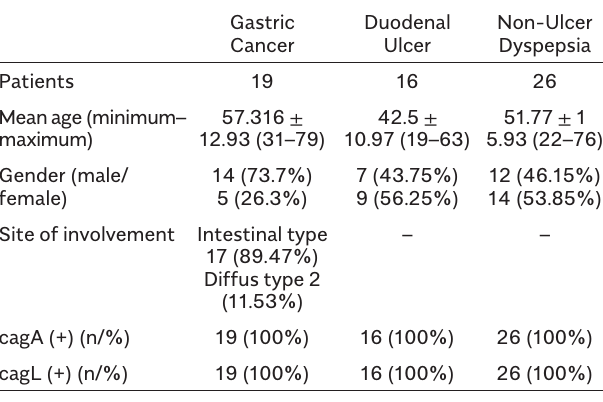
Table 2. The Baseline Characteristics and the Cancer Type of the Cases